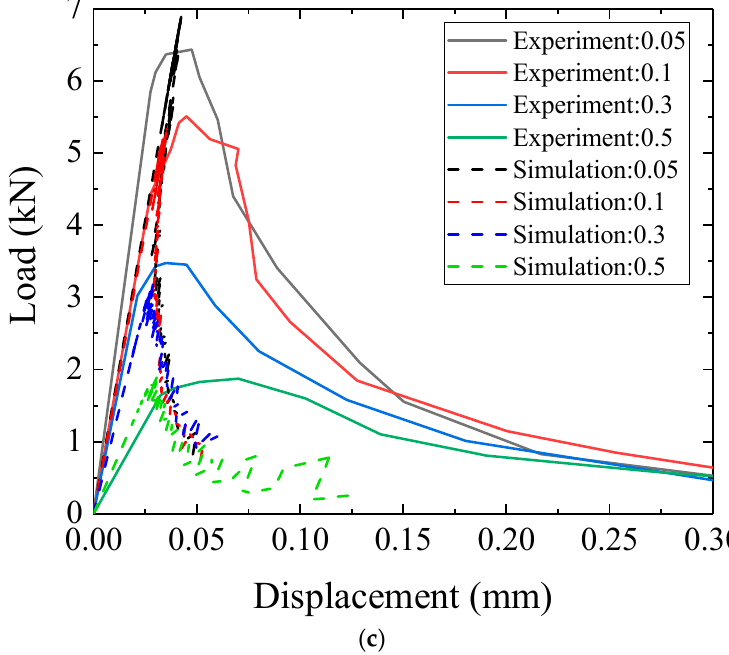
Figure 10. ( a ) Crack patterns for the smallest notch ratio, ( b ) crack patterns for the model with different notch ratio (red-cracked element) ( c ) load and displacement curve for the models with different notch ratio.